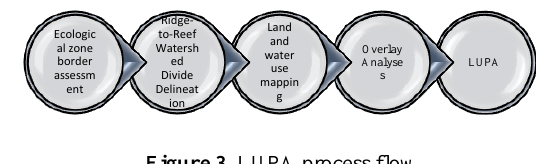
Figure 3 . LUPA process flow